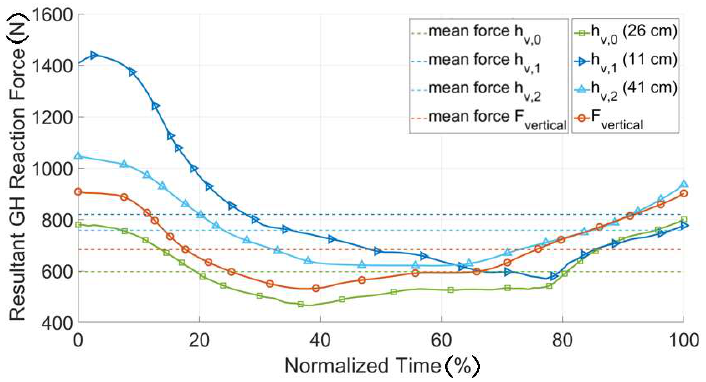
Figure 13. GHJ reaction forces for different attachment point configurations, the solid line represents the continuous joint force during the movement sequence. The dotted lines represent the mean force magnitudes for all attachment configurations.